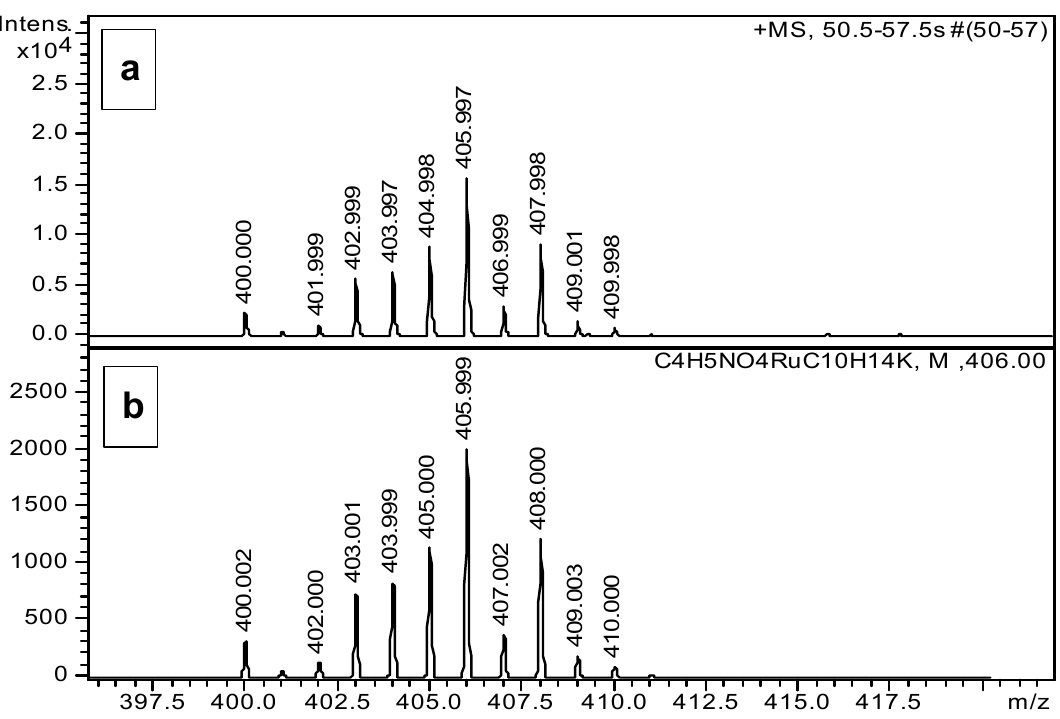
Figure 9. Measured ( a ) and calculated ( b ) isotope pattern of [( η 6 - p -cym)Ru(Ida)]+K + ion.